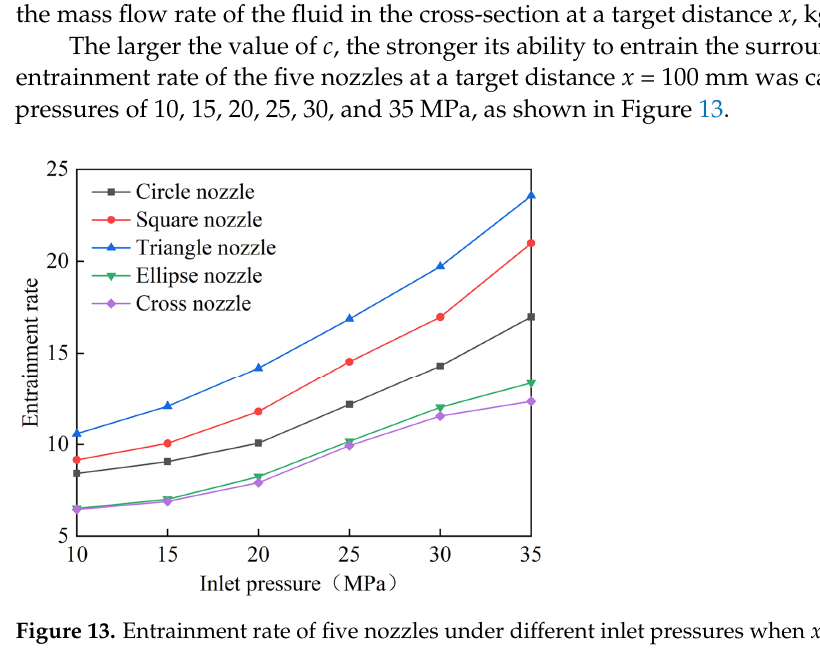
Figure 12. Effective impact area of five nozzles under different inlet pressures when x = 100 mm.